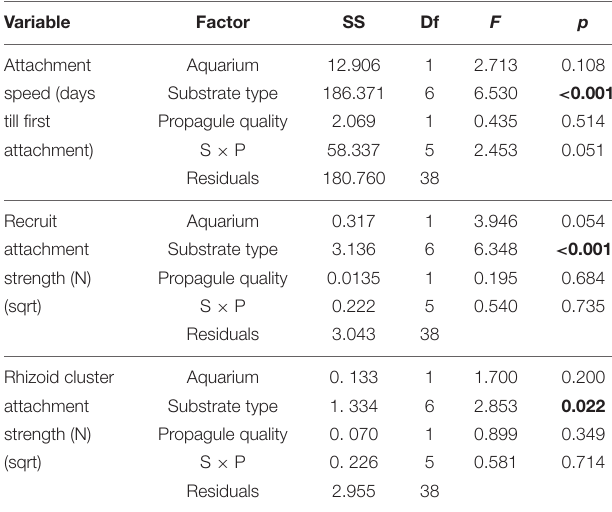
TABLE 3 | ANOVA (type II) test results on attachment performance (attachment speed, fragment- and estimated rhizoid attachment strength) for factors Substrate type and Propagule quality and their interaction measured at the end of the 10 days experimental period, with Aquarium added as blocking factor.